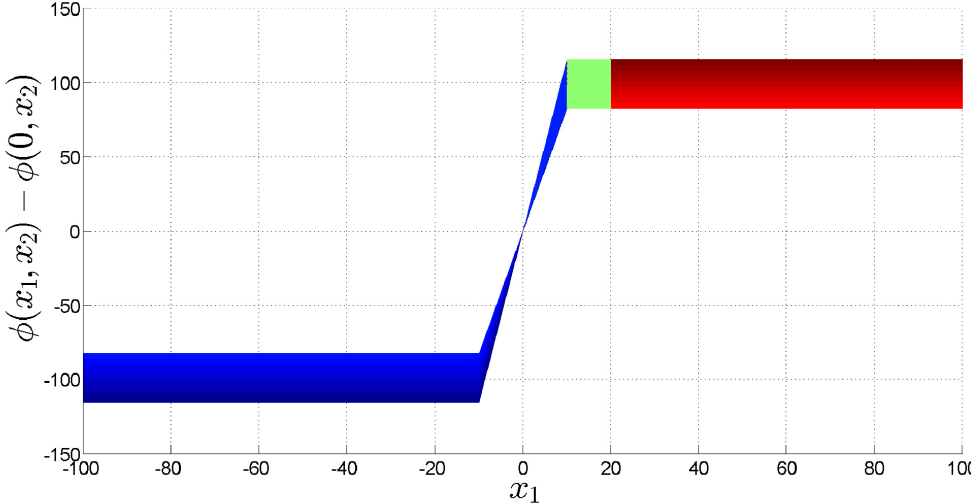
Figure 8. 3D representation of φ ( x 1 , x 2 ) – φ ( 0, x 2 ) viewed from the x 1